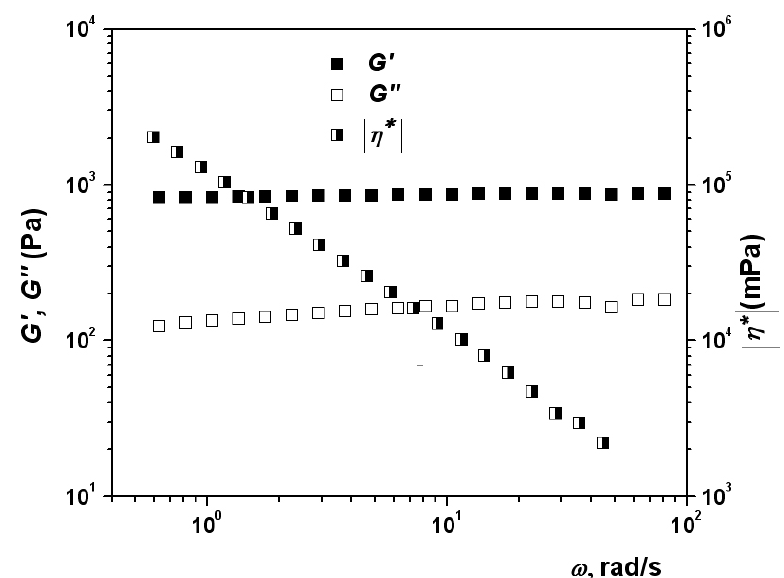
Figure 4. Angular frequency dependence of G’, G’’ and | η *| for PAAm/Dx semi-IPN gels prepared at 22 o C.